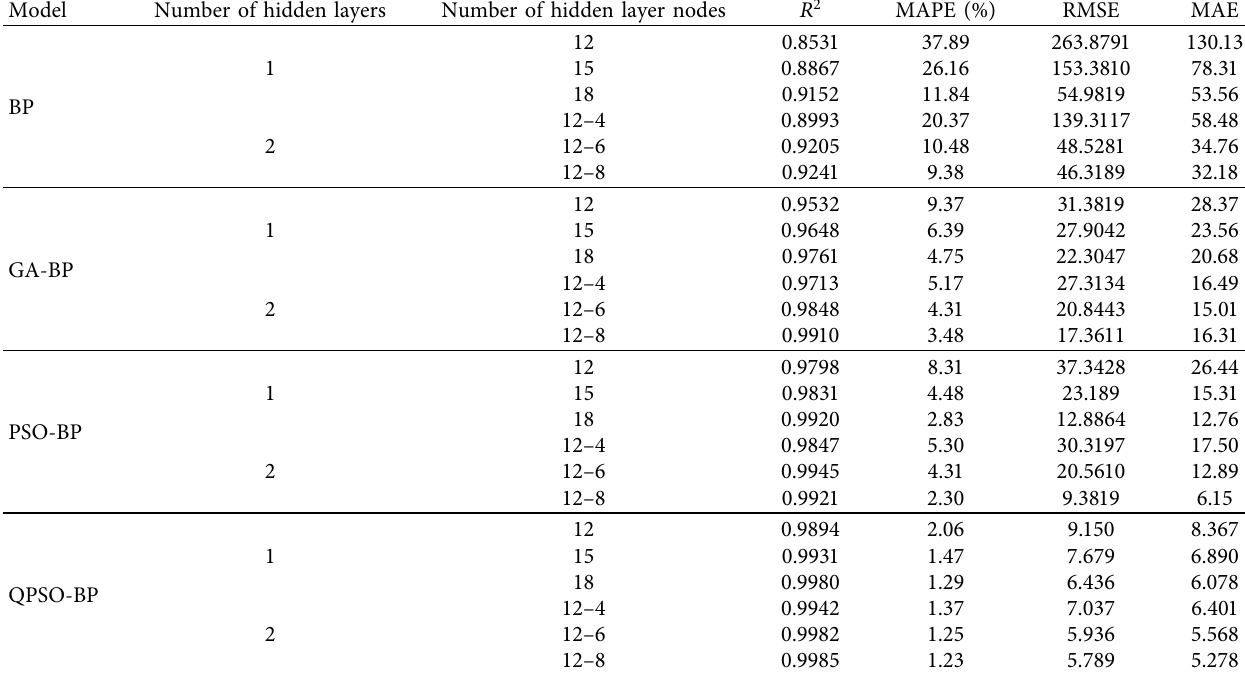
Table 7: The topological structures of the different network